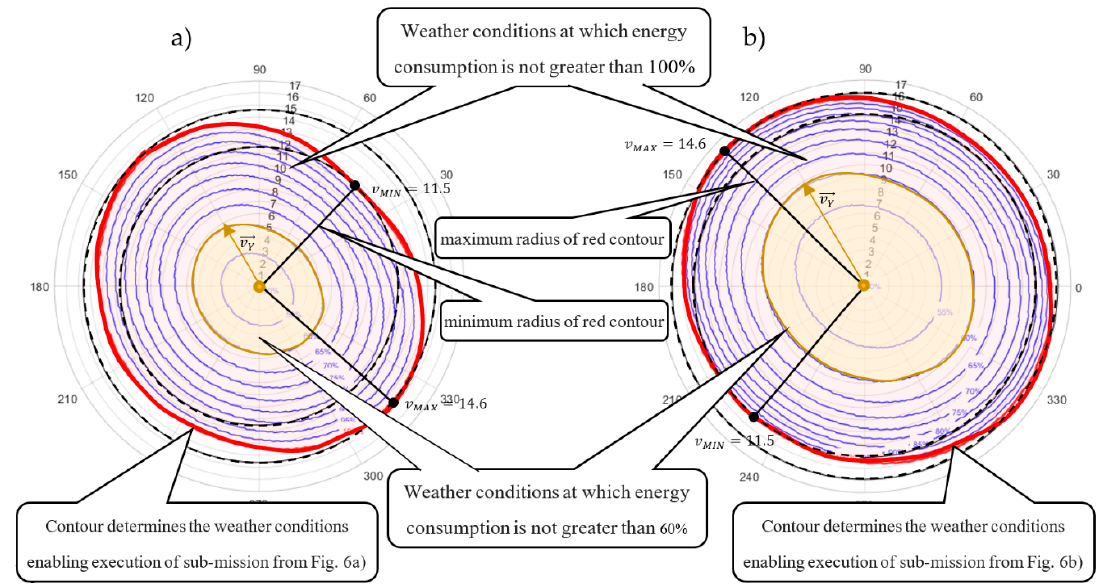
Figure 8. Radar charts of resistance to changes in wind speed: ( a ) Strategy 1; ( b ) Strategy 2.